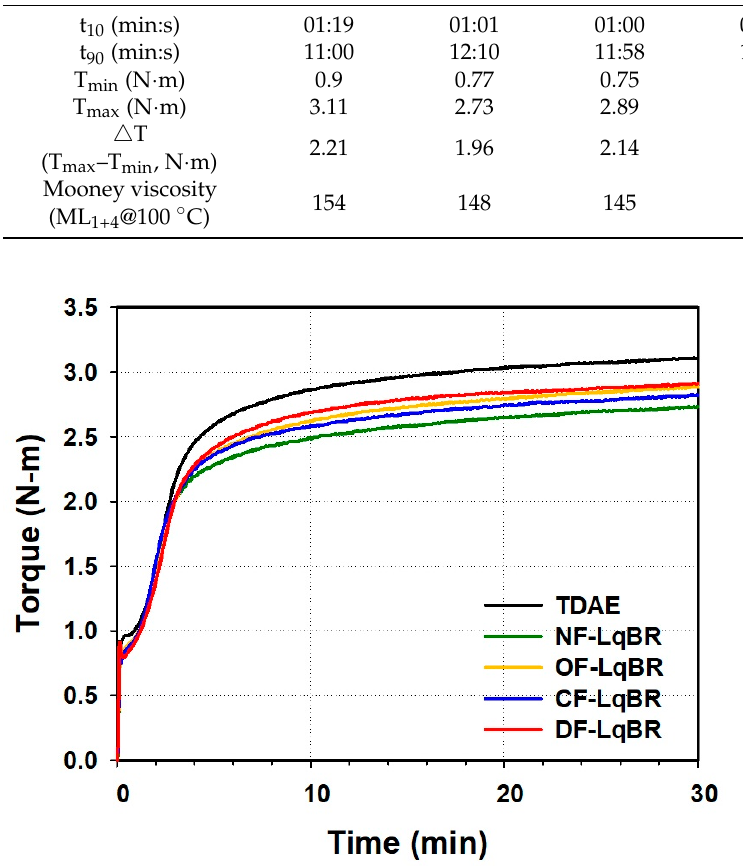
Figure 6. Cure curves of the compounds according to the applied processing aids. Table 7. Cure characteristics and Mooney viscosity of the